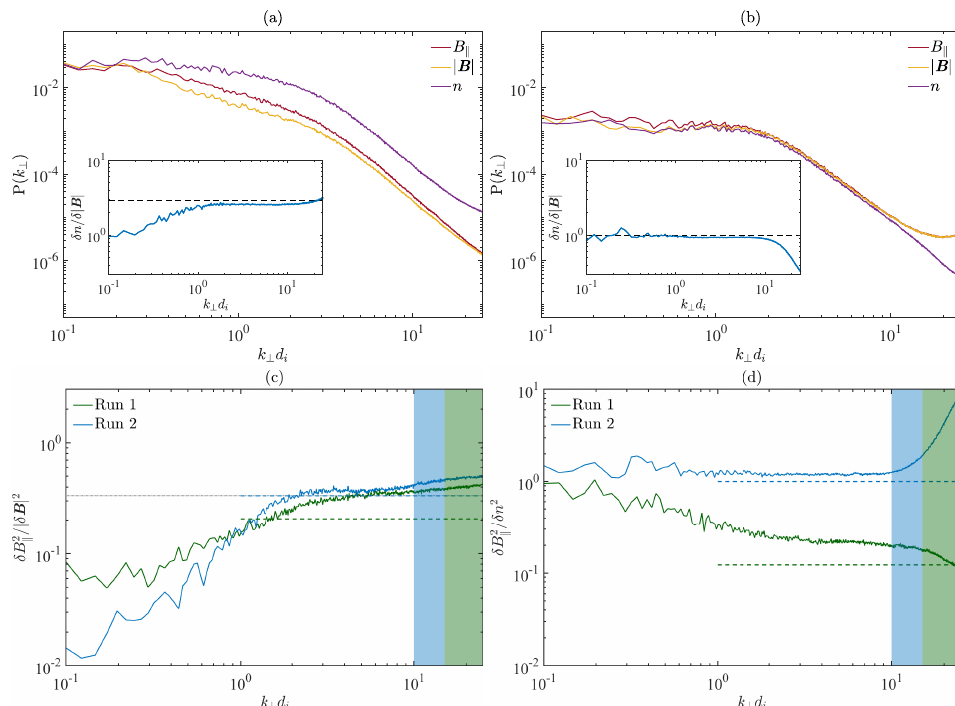
Figure 5. Spectral properties of the parallel magnetic fluctuations with respect to the ambient field, B (cid:107) , and of the density, n : ( a ) power spectra of B (cid:107) , | B | , and n for Run 1, with the ratio δ n / δ | B | in the inset; ( b ) same as for panel ( a ) but for Run 2; ( c ) magnetic compressibility δ B 2 and Run 2, compared with theoretical predictions (see text); ( d ) ratio δ B 2 compared with theoretical predictions (see text). The shaded areas in panels ( c , d ) mark the scales at which the noise significantly affects the spectra in the two